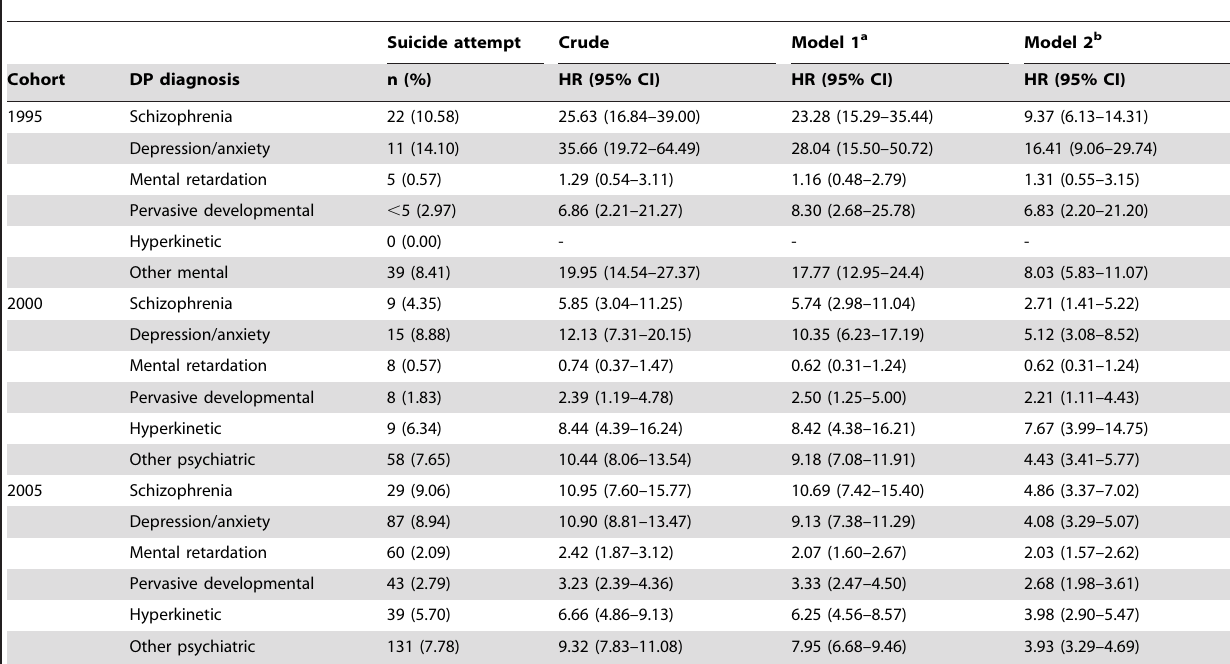
Table 6. Hazard ratios (HR) and 95% confidence intervals (CI) for suicide attempt during a five-year follow-up of young adults with disability pension (DP) due to specific psychiatric diagnoses in 1995, 2000 and 2005, respectively 1 .